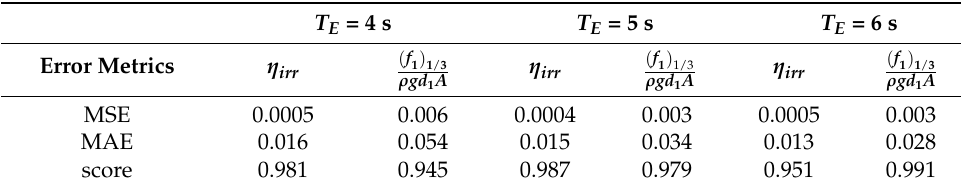
Table 2. Error metrics of two output features for three different energy periods.